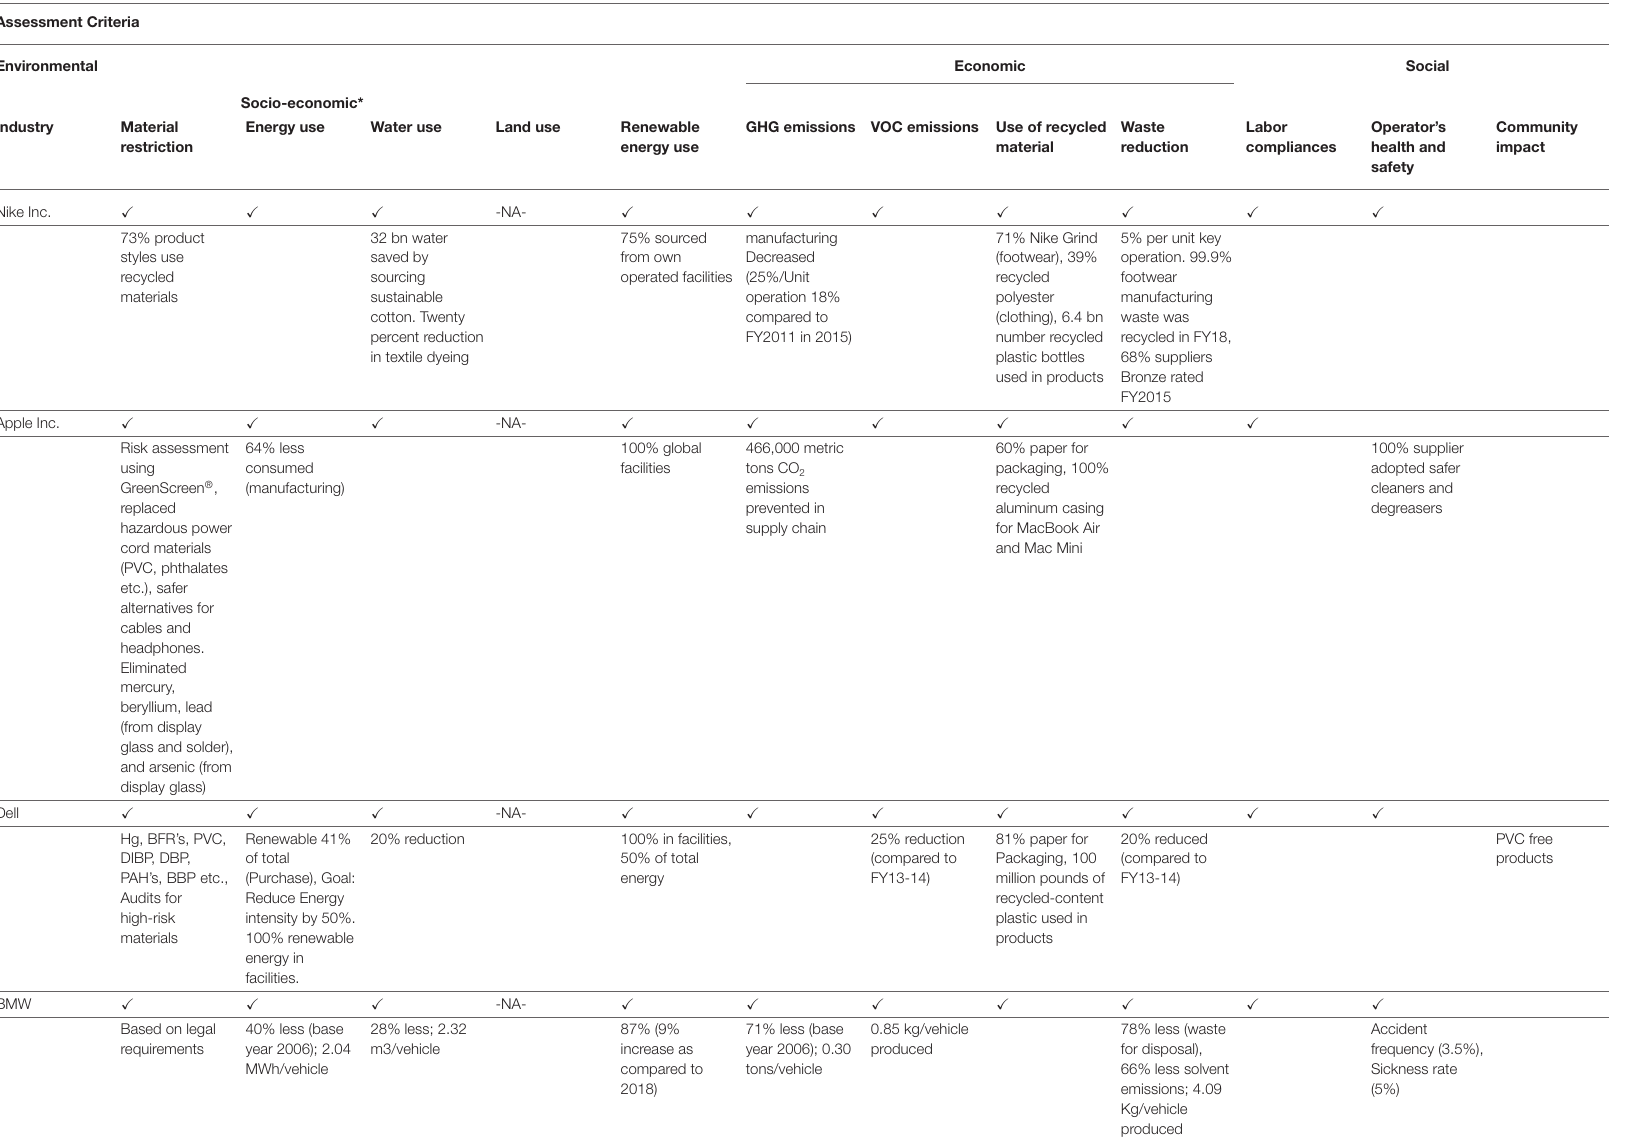
* Refers to Socio-Economic considerations leading to economic benefits (either to company and eventually to